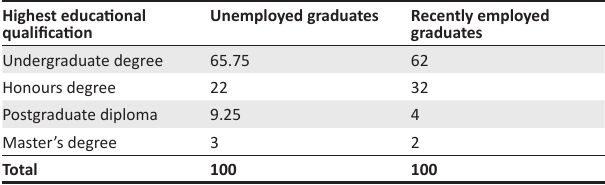
TABLE 2: Educational level of respondents ( % ).